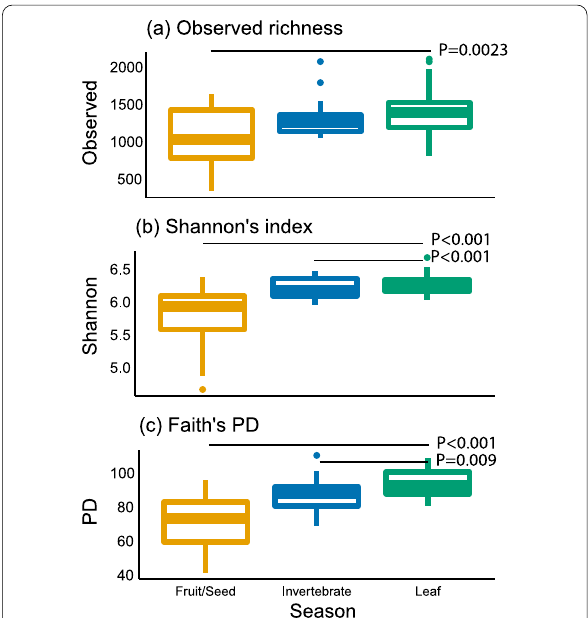
Fig. 3 Alpha diversity indices of Japanese macaque gut microbiota. ( a ) Observed richness. ( b ) Shannon’s diversity index. ( c ) Faith’s phylogenetic diversity